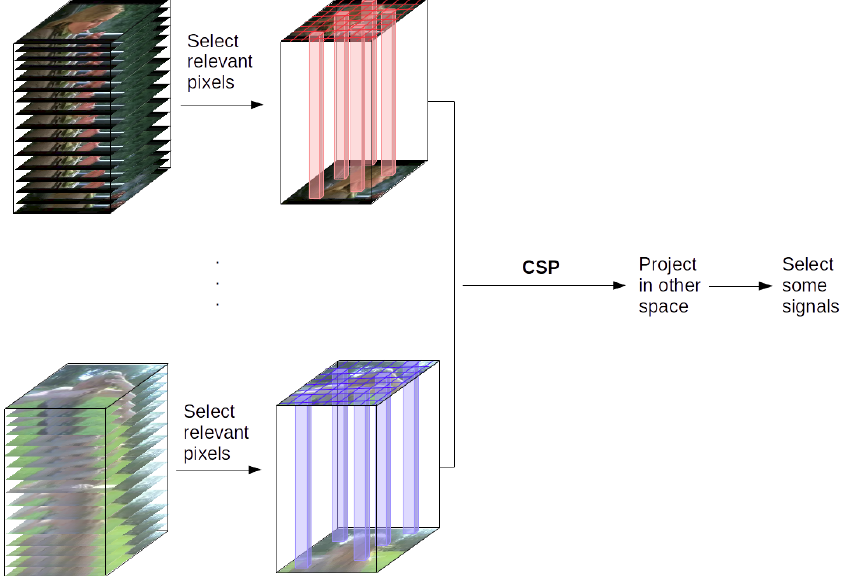
Figure 1. Proposed approach.